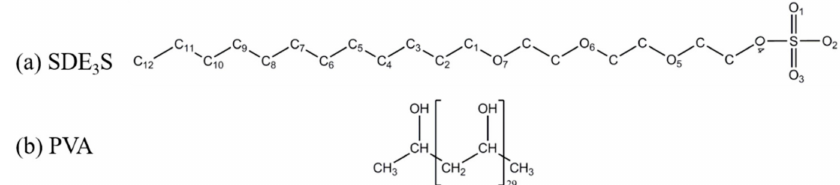
Figure 2. Molecular structures of ( a ) sodium dodecyl ether sulfate containing three oxide groups (SDE 3 S) and ( b ) polyvinyl alcohol (PVA).